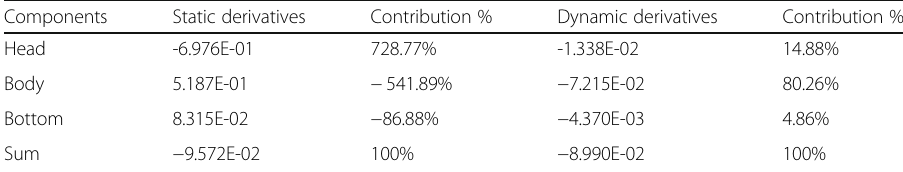
Table 1 Contribution of head, body and bottom part to the overall stability Components Static derivatives Contribution % Dynamic derivatives Contribution % Head -6.976E-01 728.77% -1.338E-02 14.88% Body 5.187E-01 − 541.89% − 7.215E-02 80.26% Bottom 8.315E-02 − 86.88% − 4.370E-03 4.86% Sum − 9.572E-02